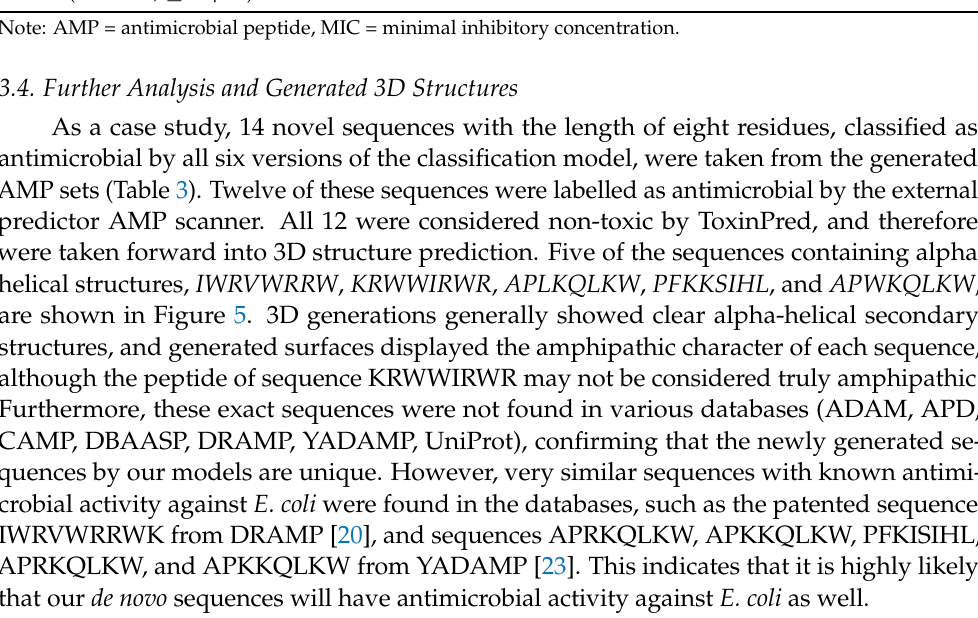
Table 3. Further analysis results of the 14 antimicrobial peptide (AMP) sequences in the case study.